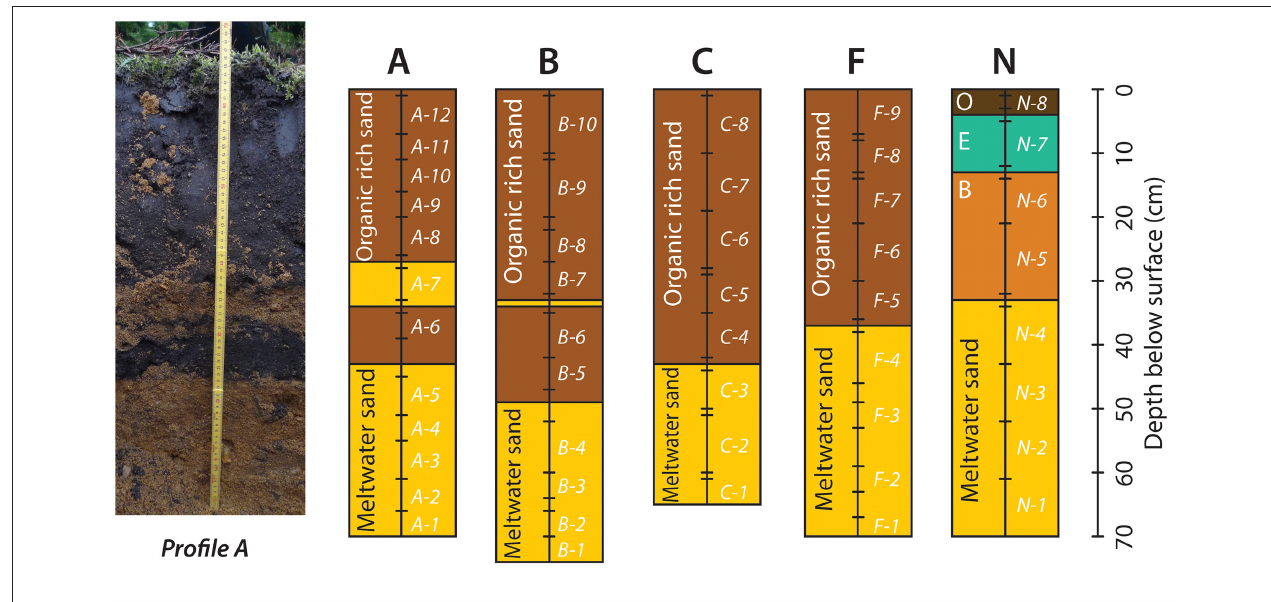
FIGURE 2 | Photograph of soil profile A, and schematic drawings of the 5 soil profiles with lithologies and sampling depth. See Figure 1 for the position of the soil profiles. Photo by Claus Heilmann